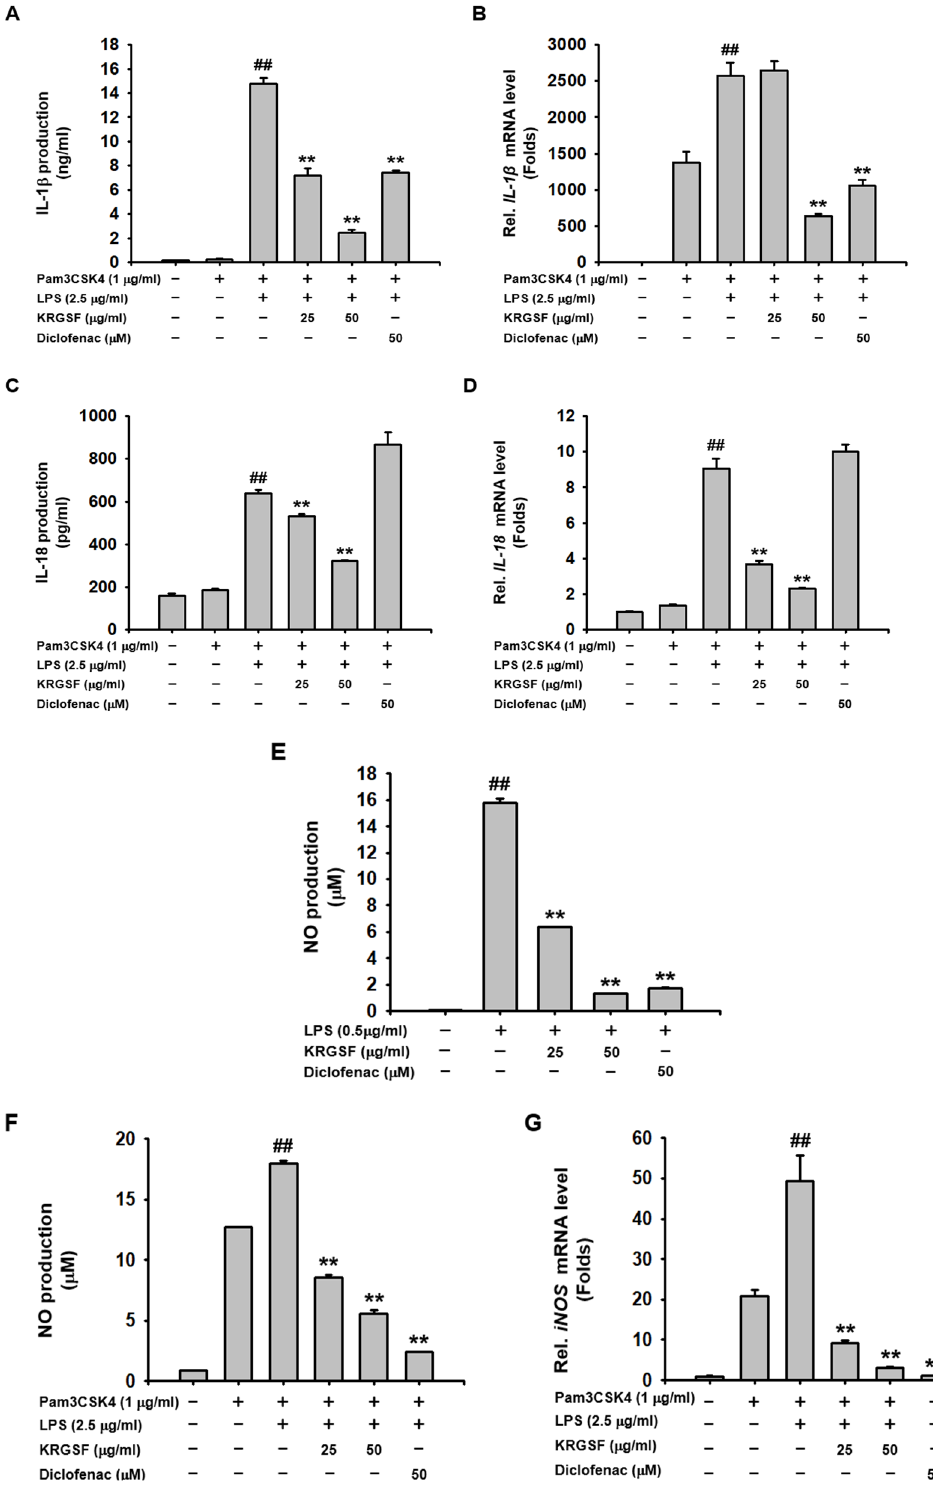
Figure 2. Suppressive role of KRGSF on caspase-11 non-canonical inflammasome-activated produc- tion of inflammatory mediators in J774A.1 cells. J774A.1 cells pretreated with the indicated doses of KRGSF or diclofenac (50 μ M) for 1 h were treated with Pam3CSK4 (1 μ g/mL) for 4 h and transfected with LPS (2.5 μ g/mL) for 24 h. ( A ) IL-1 β and ( C ) IL-18 in the media were examined by ELISA. mRNA of ( B ) IL-1 β , ( D ) IL-18, and ( G ) iNOS were quantified by qPCR. NO in the media of J774A.1 cells pretreated with the indicated doses of KRGSF or diclofenac (50 μ M) for 1 h, treated with ( E ) LPS for 24 h or ( F ) Pam3CSK4 (1 μ g/mL) for 4 h, followed by transfection with LPS (2.5 μ g/mL) for 24 h were examined by a Griess assay. ( A – D , F , G ) ## p < 0.01 compared to the Pam3CSK4-treated control;